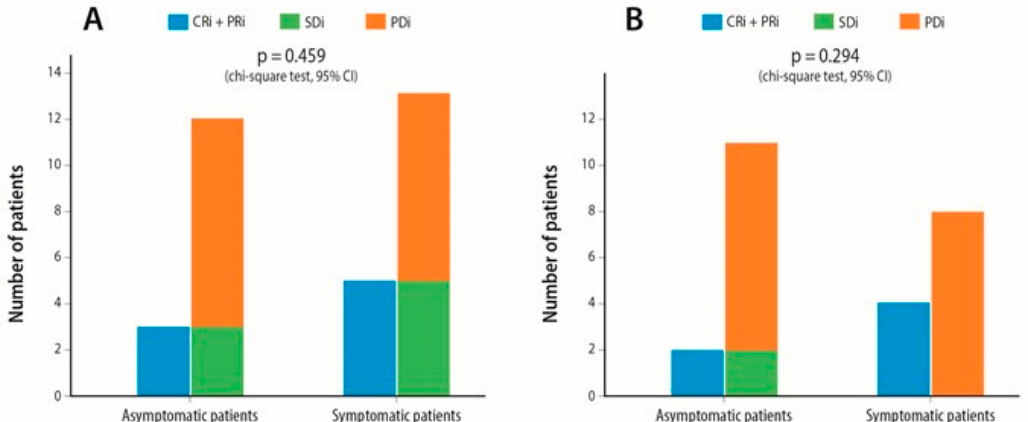
Figure 2. Association between presence of symptoms attributed to brain metastases and intracranial overall response rate; p-value of overall response rate (blue bars) between symptomatic and asymptomatic patients are shown in each graph ( A ) In the whole patient population that was included for response assessment ( B ) In the subgroup of patients with active brain metastases. Abbreviations: 95% CI = 95% Confidence Interval, CRi = Intracranial Complete Response, PRi = Intracranial Partial Response, SDi = Intracranial Stable Disease, PDi = Intracranial Progressive Disease.